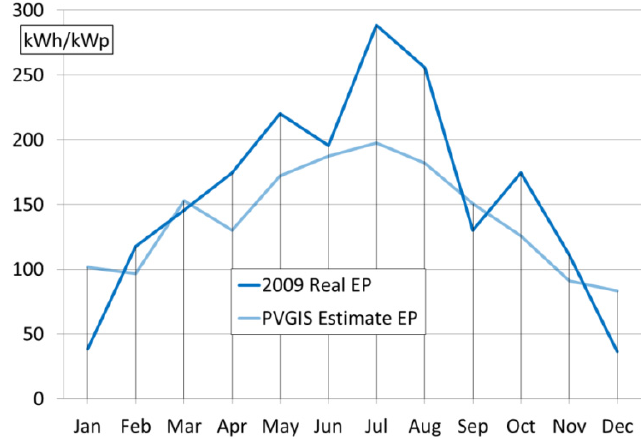
Figure 6. Real EP and monthly EP estimate from PVGIS for Puertollano CPV installation in 2009.